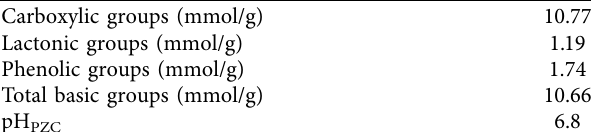
Table 3: Surface chemical properties of the obtained adsorbent.